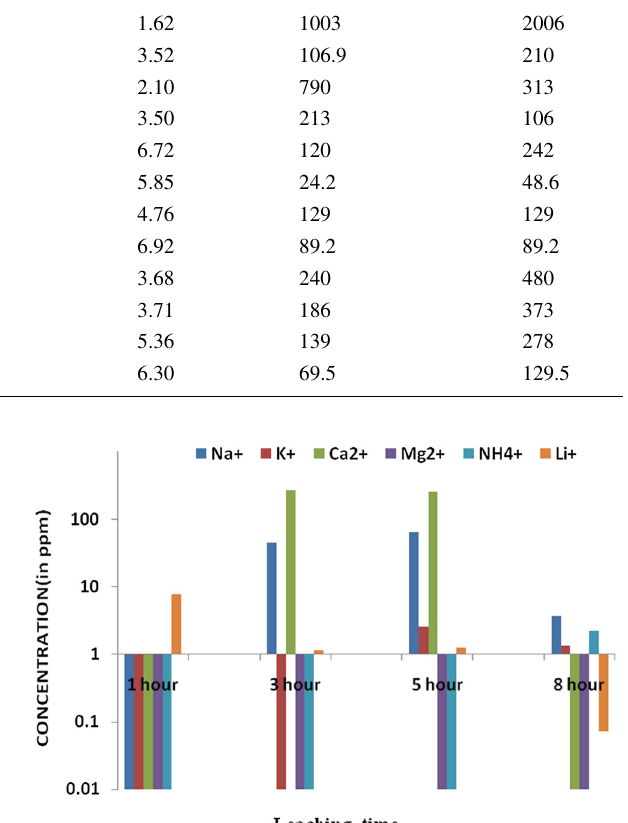
Fig. 5 Change in concentration (in ppm) of cations in aqueous leachates with leaching time (in hour) of Ledo overburden (LOB- 15A) at 25 (cid:3) C